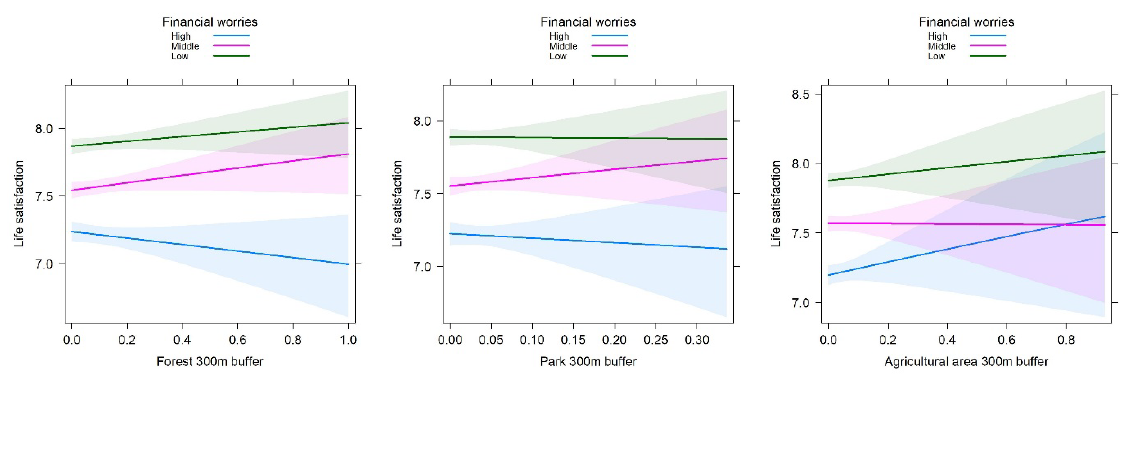
Figure S5 . Mutually adjusted greenspace associations on life satisfaction by financial worries, adjusted for life satisfaction in the past, age categories, sex, household income, canton, degree of urbanisation, and month of